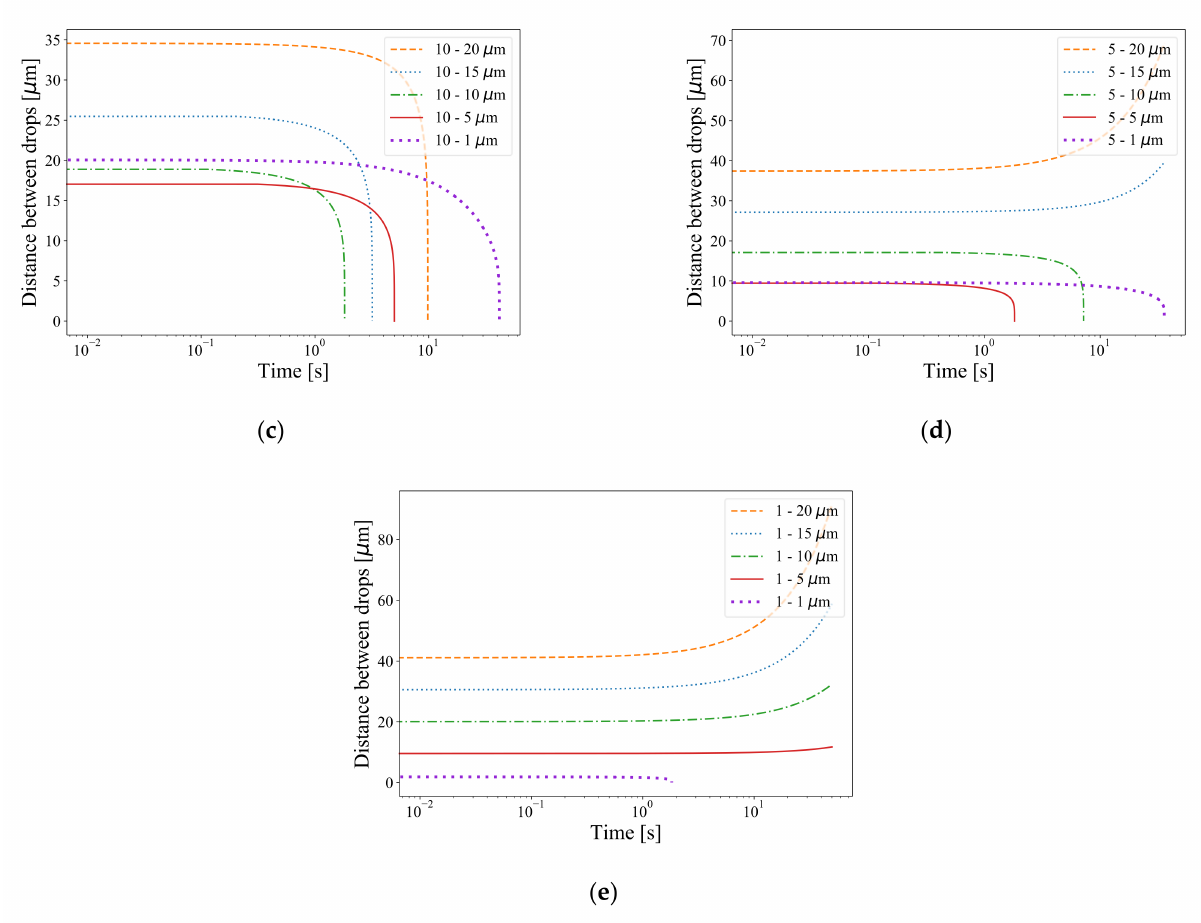
Figure 6. Effect of different droplet sizes of 5, 10, 15 and 20 µ m for ( a ) upper droplet of 20 µ m, ( b ) upper droplet of 15 µ m, ( c ) upper droplet of 10 µ m and ( d ) upper droplet of 5 µ m. ( e ) upper droplet of 1 µ m.